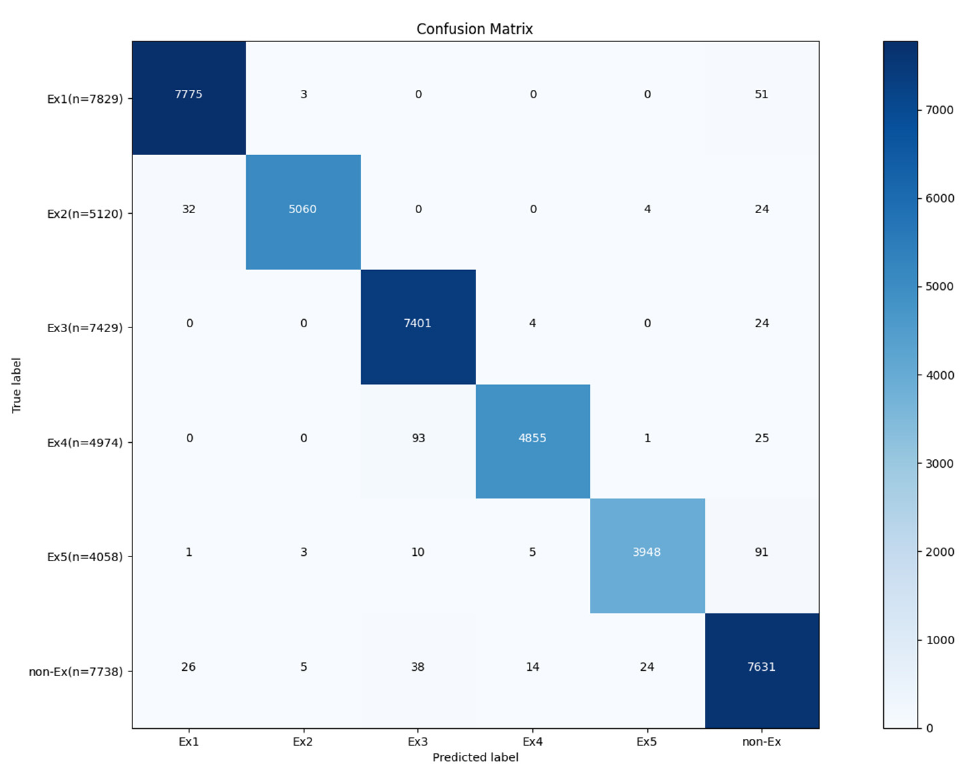
Figure A6. Confusion matrix for IMU input model.